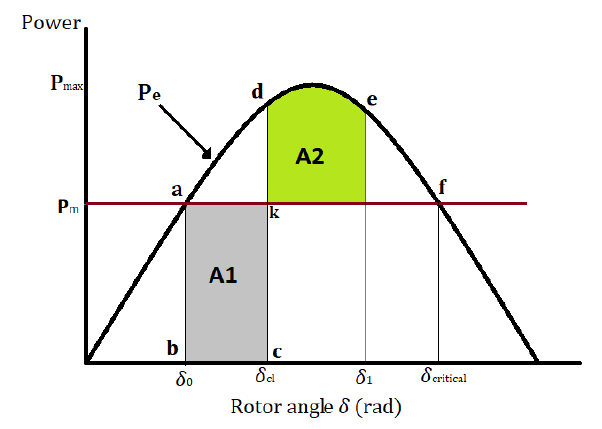
Figure 4. Equal area